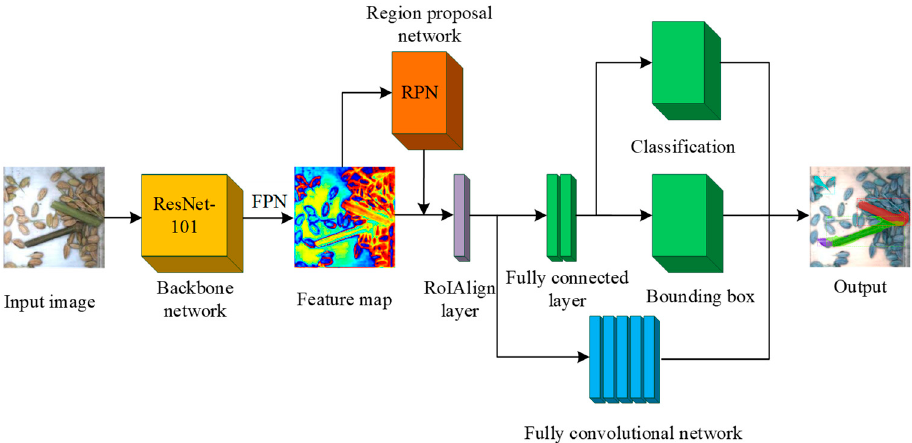
Figure 5. Flowchart of rice impurity recognition algorithm based on Mask R-CNN.